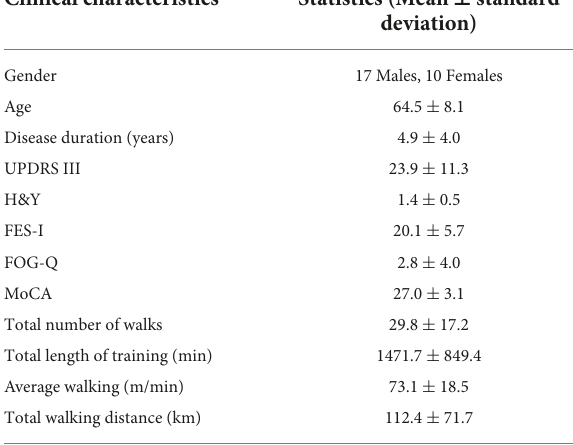
TABLE 1 Demographic and clinical information on PD